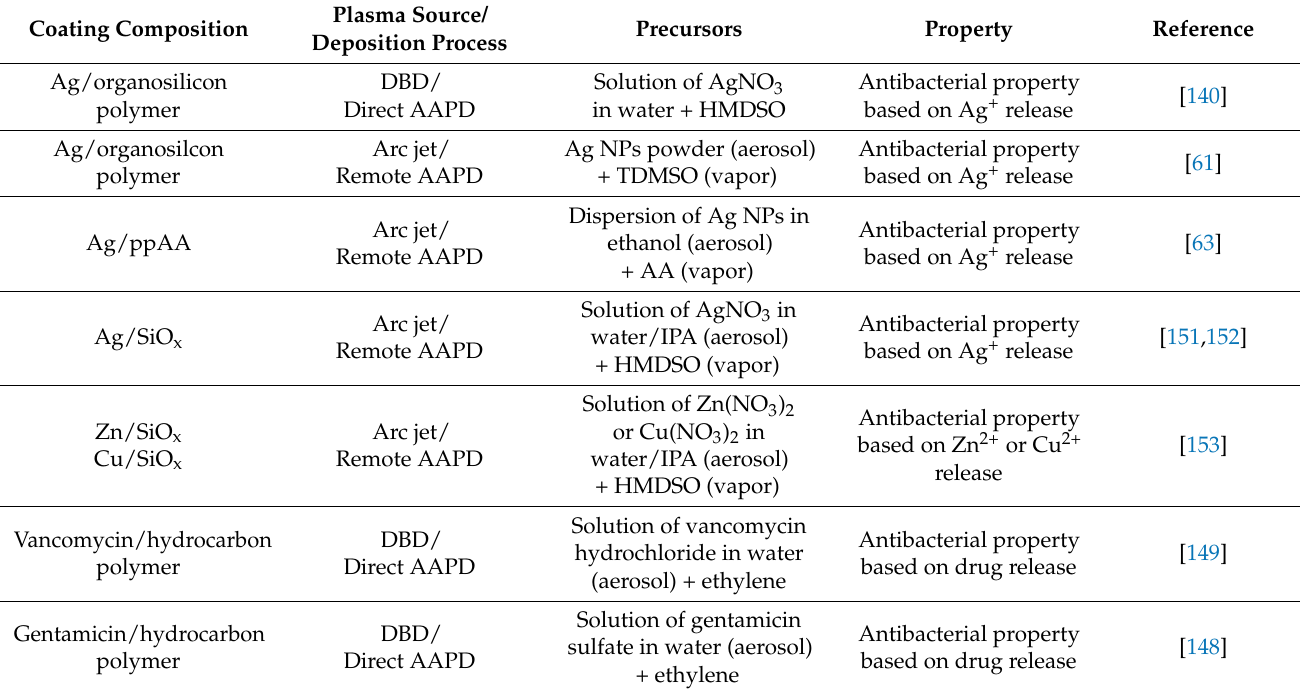
Table 3. Representative studies on antibacterial NC coatings deposited by